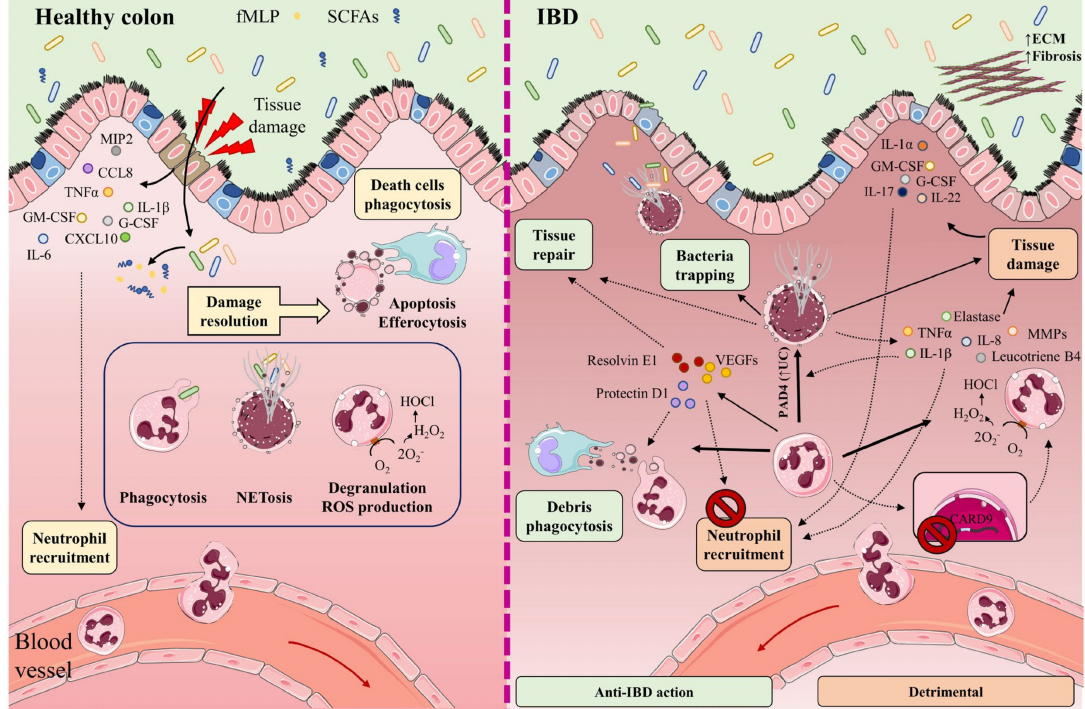
Figure 1. In healthy intestine ( left ), damage to the intestinal barrier triggers the recruitment of neutrophils from the circulation to the inflamed tissue along a chemotactic gradient formed by